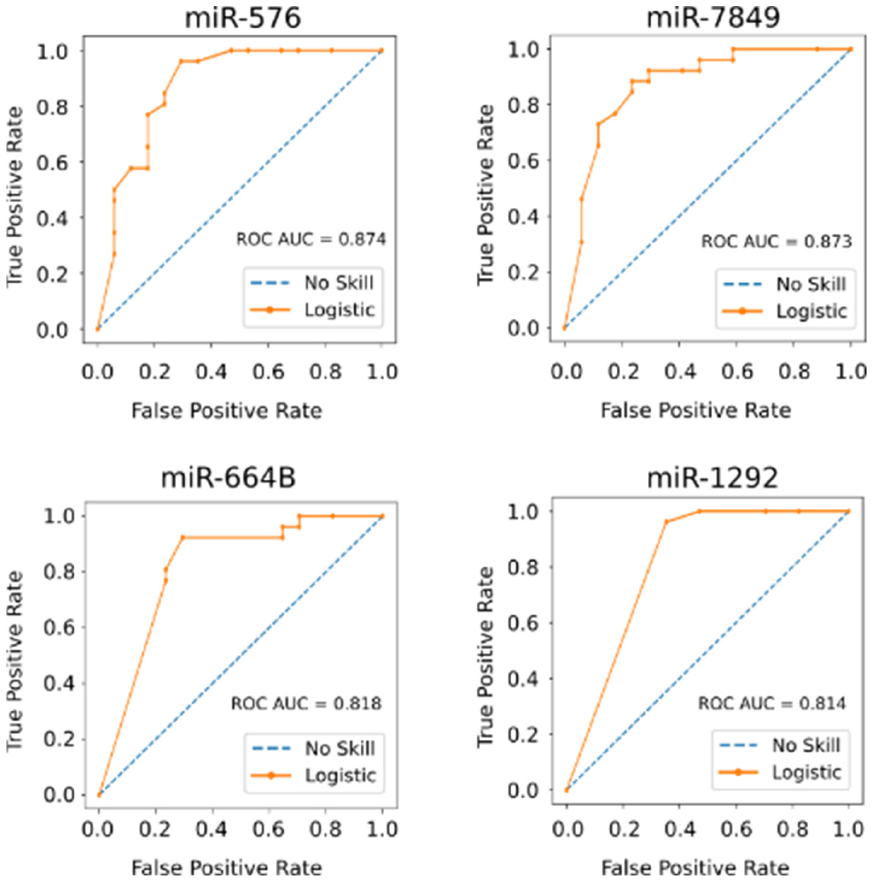
Figure 3. Four miRNAs show a very good ability to distinguish between the HCC and non-HCC group during treatment of HCV infection. The area under the curve (AUC) for each Receiver Operating Characteristic (ROC) curve based on logistic regression models for each RNA species was calculated. All samples throughout the time course of this study were used as test group .